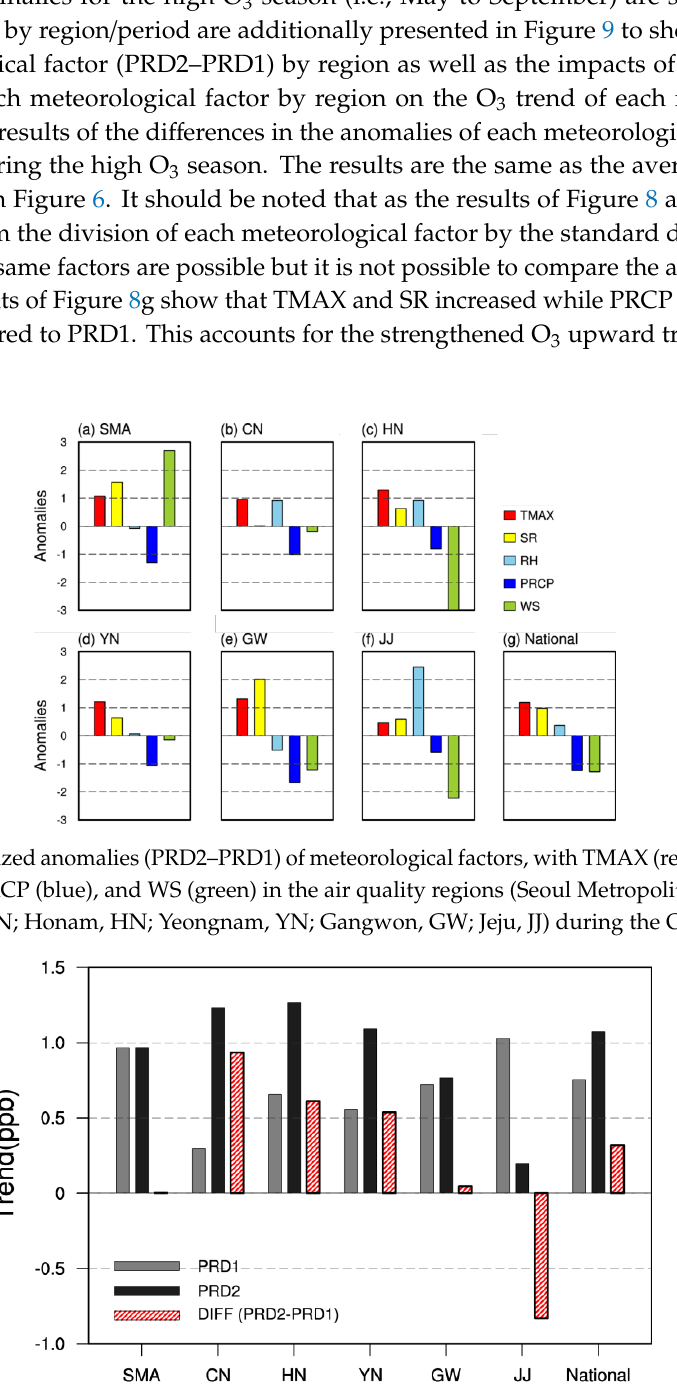
Figure 9. Annual O 3 trends during PRD1 (grey) and PRD2 (black) in different air quality regions and their differences (red).